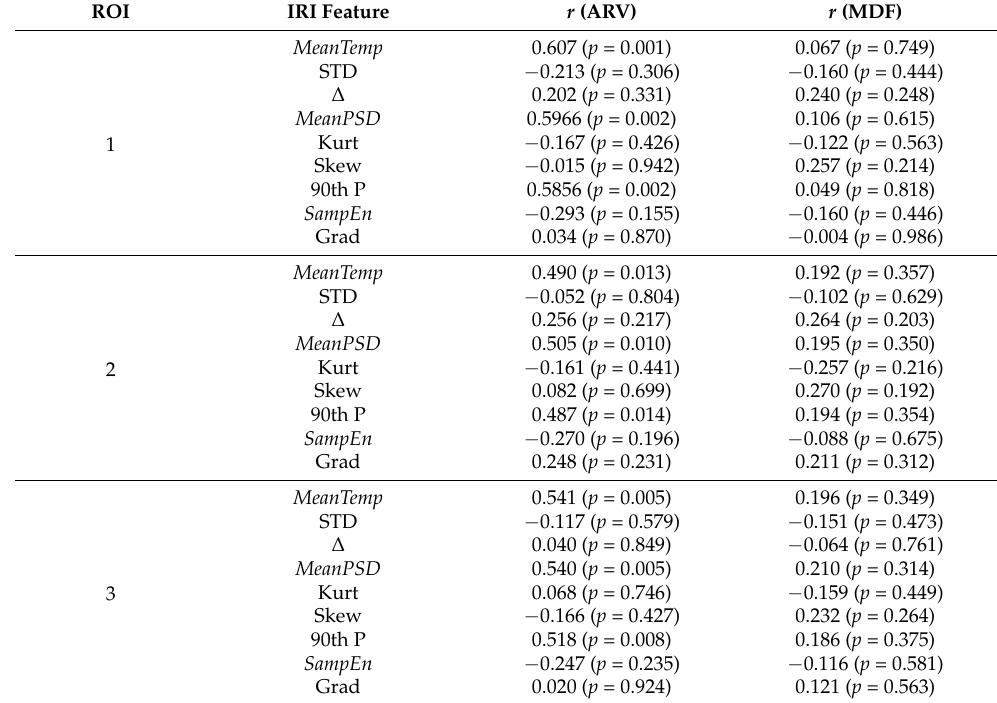
Table 1. Correlation coefficients ( r ) computed between the ARV and MDF and the IRI features used as input to the ML